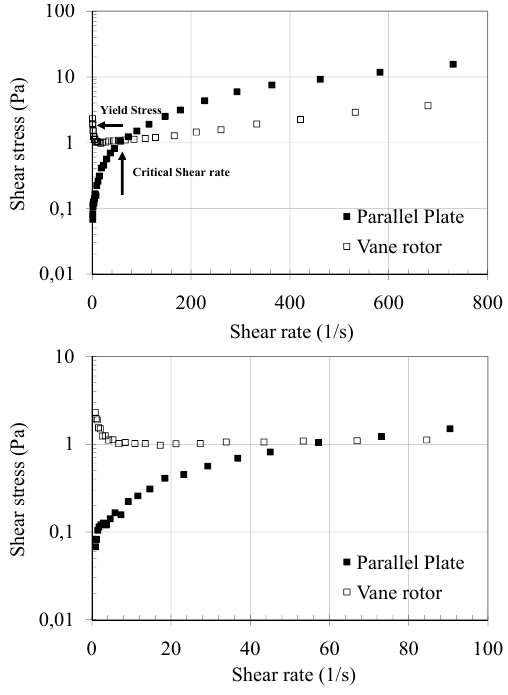
Fig. 5. Material A, C v = 20%. Comparison between the experi- mental results obtained with the parallel plates and the vane rotor